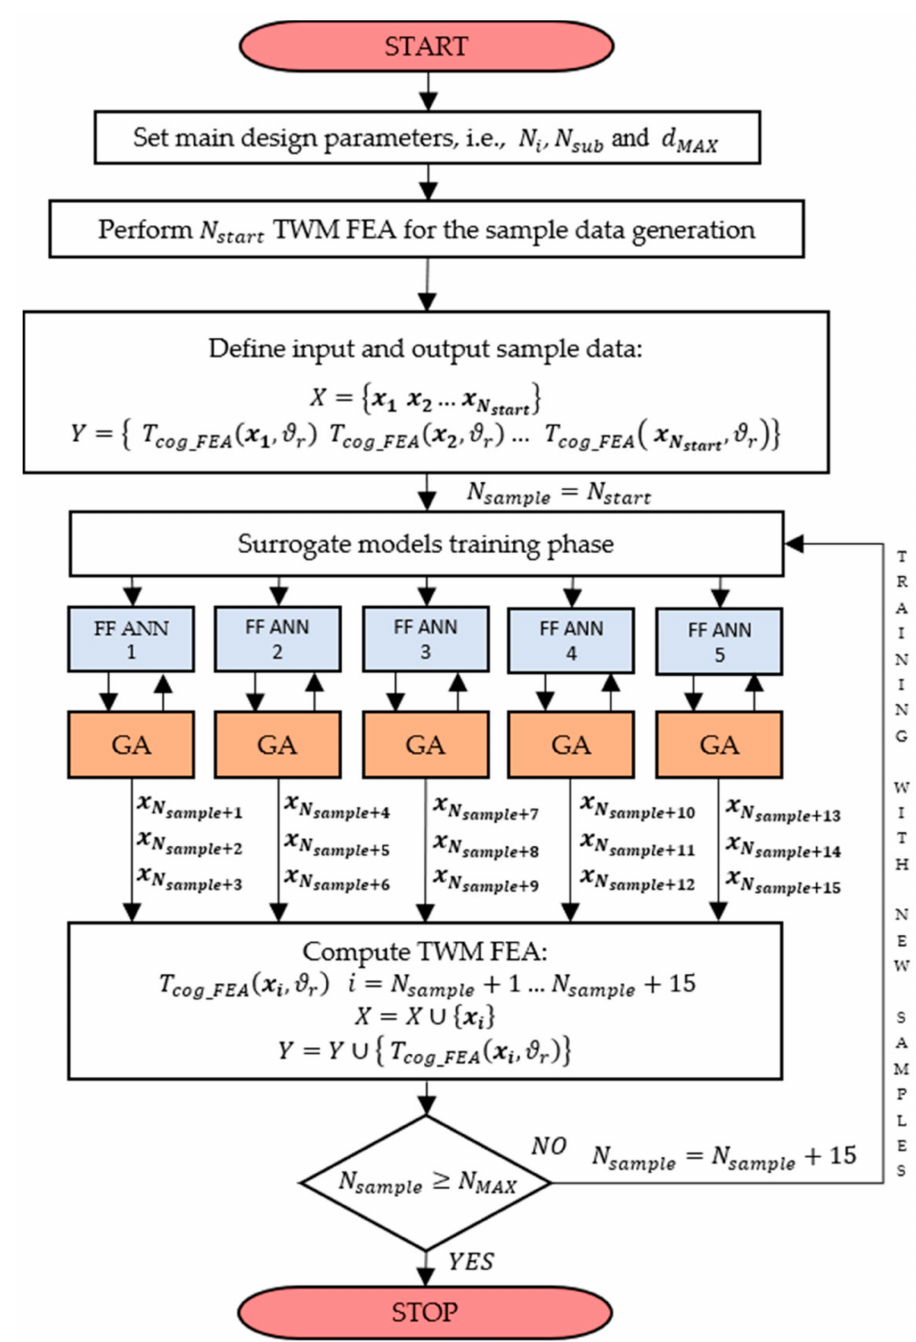
Figure 6. Flow chart of the proposed heuristic